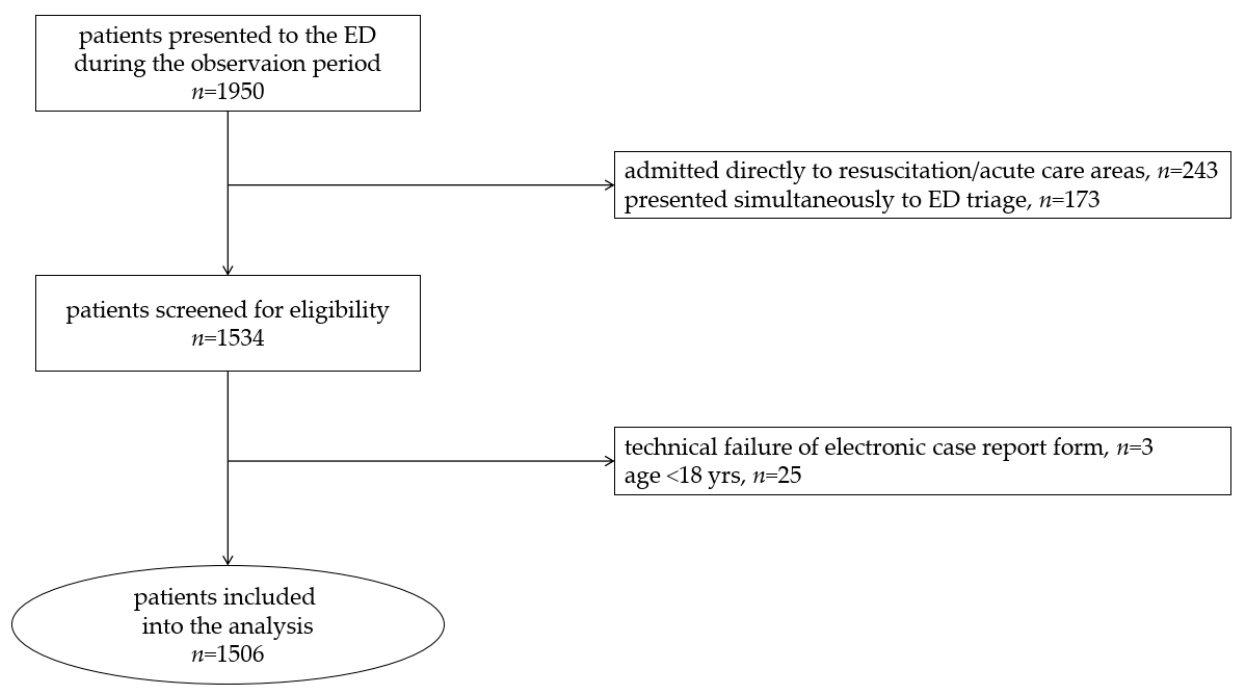
Figure 1. CONSORT flow diagram. ED, emergency department. Table 1. Characteristics of study patients.